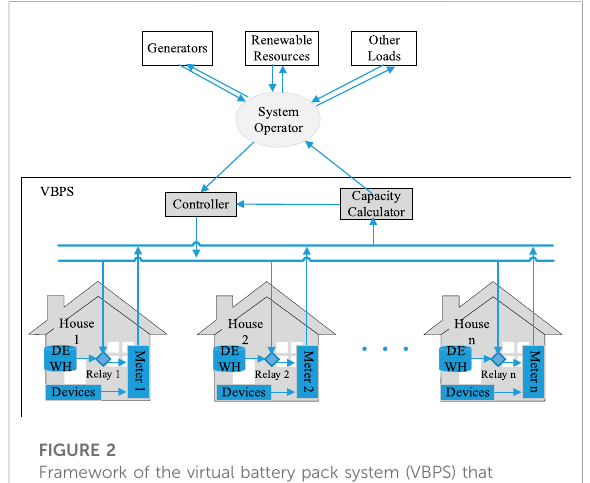
FIGURE 2 Framework of the virtual battery pack system (VBPS) that provides frequency control in the power